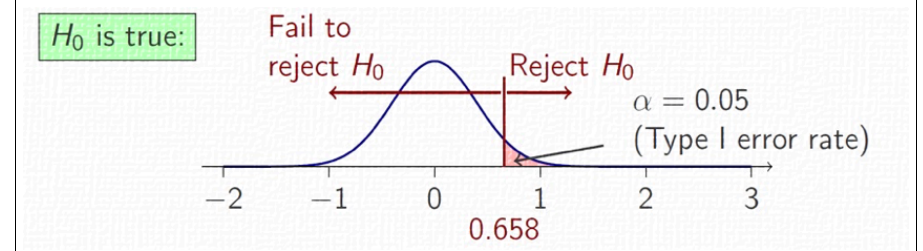
Figure 5. A graphical explanation of the hypothesis testing process for a generic one-sided test with alternative hypothesis H 1 : A > B and α = 0.05. The area under the normal distribution, highlighted in red, is equal to α and indicates the rejection zone. Indeed, any x > 0.658 would return a p -value (i.e., area under the distribution) lower than α , thus rejecting H 0 . Conversely, for all x < 0.658, the corresponding p -value would be greater than α , thus failing to reject H 0 . In a two-sided test, the red area on the right-hand side should have a symmetric counterpart on the left-hand side. The two = 0.05 resulting tails, each one casting an area of 0.025 (i.e., α , so that the total significance level is 0.05 2 2 and the corresponding confidence is 1 − α = 95%) would form the rejection